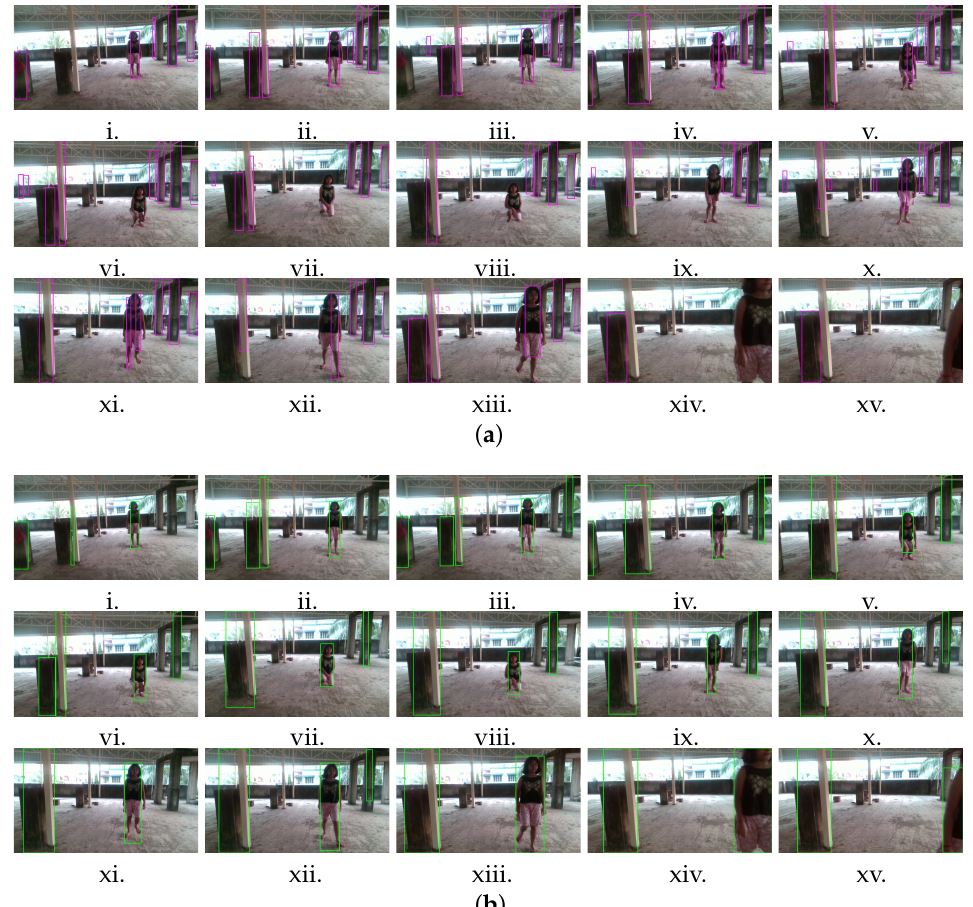
Figure 21. Comparison of the proposed method with VbOAD [28] algorithm with a dynamic obstacle that changed its shape and size abruptly on the run. ( a ) ( i – xv ) Time-sampled snapshots with the output of VbOAD. ( b ) ( i – xv ) Time-sampled snapshots with the output of our proposed